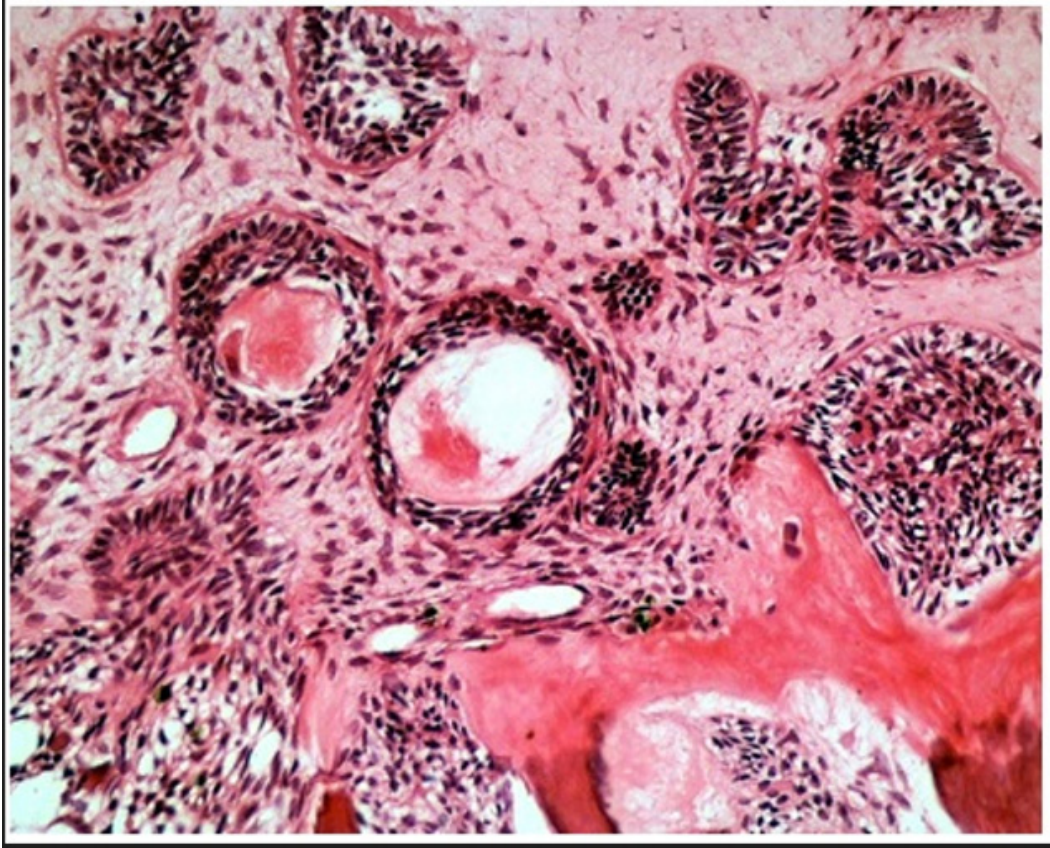
Figure 6. Specimen–removed calcified bodies of varying shapes and sizes compatible with odon ‐ togenic tissue and the unerupted tooth 47 (black arrow). Courtesy of Dr. W. Pawlak.